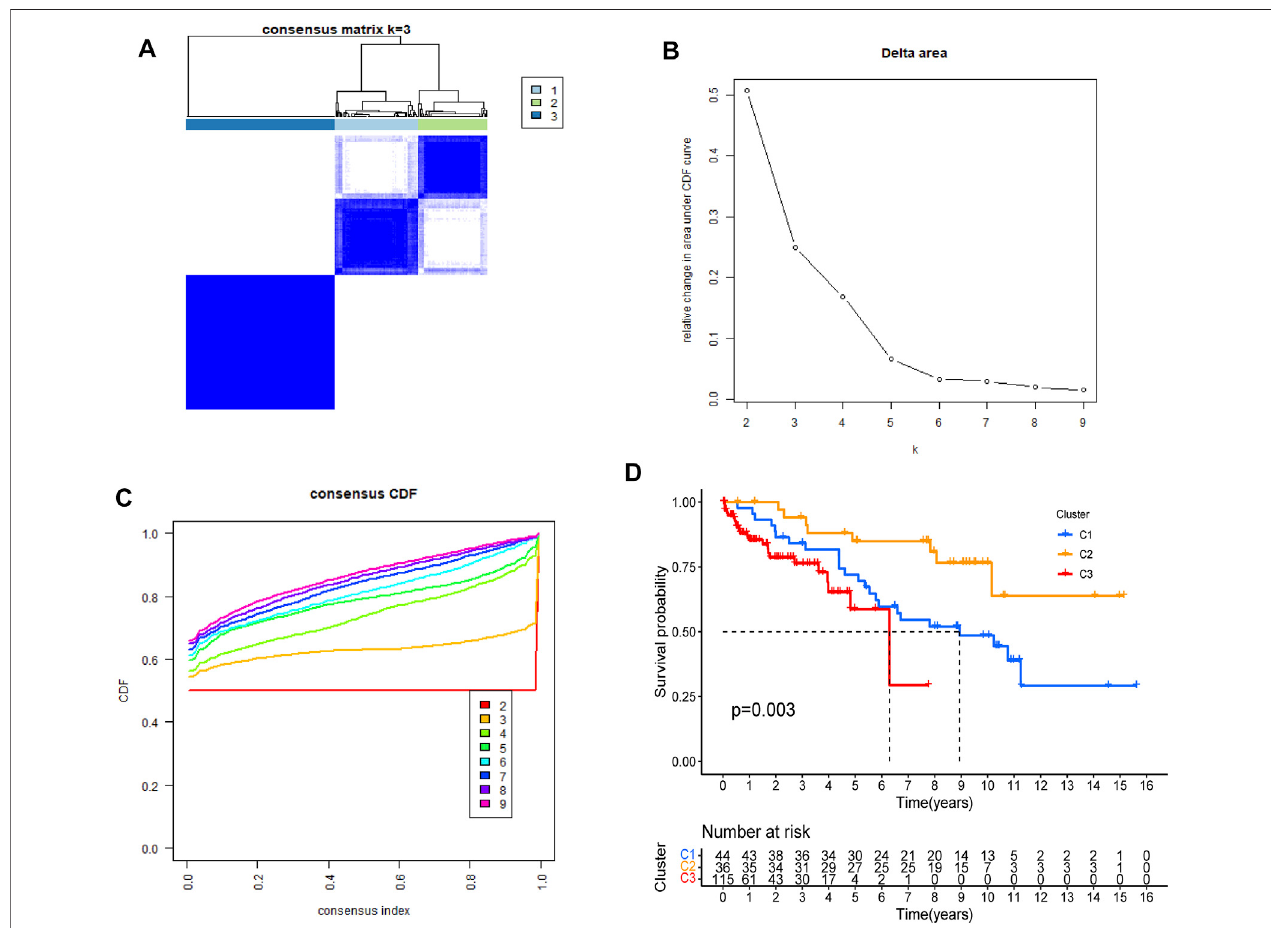
FIGURE 3 | Identi fi cation of DRGs-based molecular subtypes of HCC patients from GEO datasets (A – C) three HCC molecular subtypes were identi fi ed at a clustering threshold of maxK = 9 (D) . Kaplan-Meier analysis of the survival rates associated with the three subtypes.